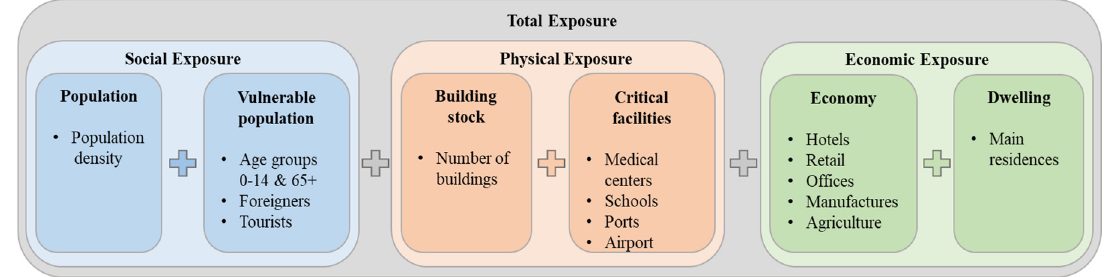
Figure 2. Total Exposure calculation framework.